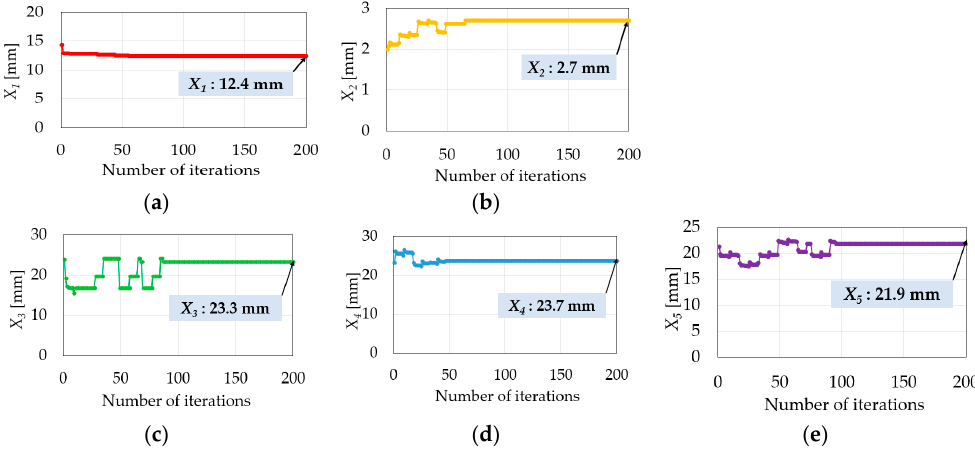
Figure 8. Convergence profiles of design variables: ( a ) X 1 ; ( b ) X 2 ; ( c ) X 3 ; ( d ) X 4 ; ( e ) X 5 .